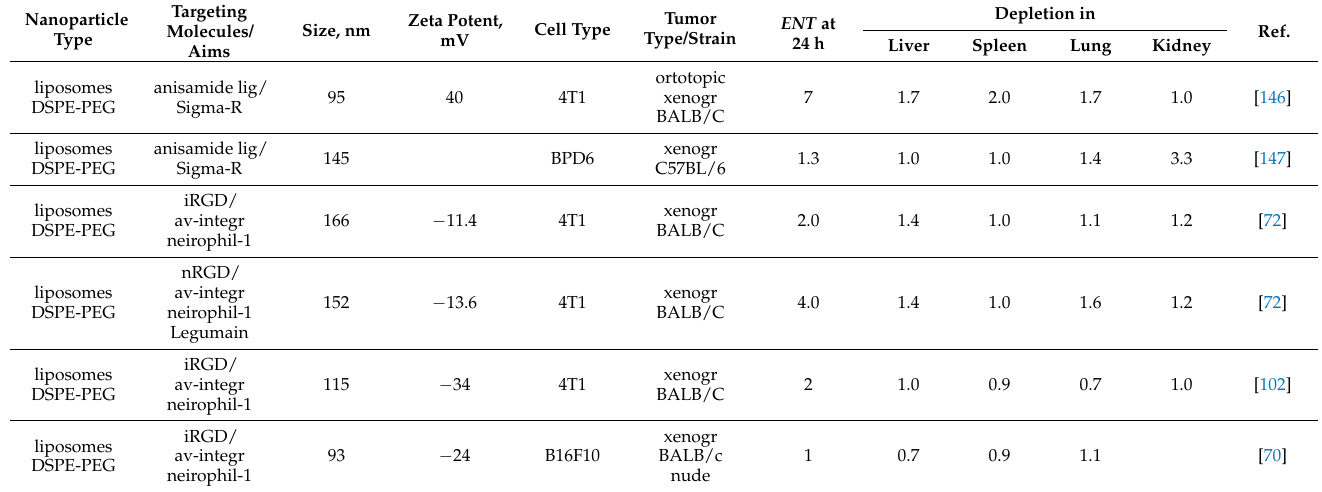
Table 2. Changes in the biodistribution for DSPE-PEG liposomes are sorted by the depletion of nanoparticles in the spleen by targeting